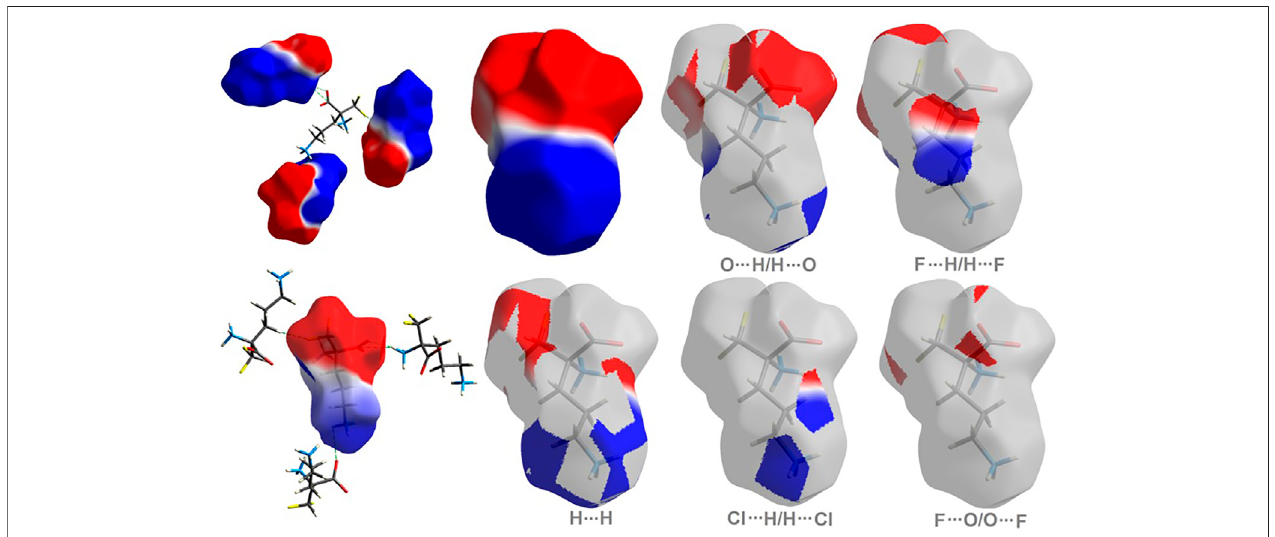
FIGURE 4 | On the left: the molecular ESP mapped on the HS of 1 . On the right: surface patches identi fi ed with decomposed close contacts in crystal 1 . Red regions (acceptors) correspond to the negative electrostatic potential, while blue (donors) to the positive electrostatic